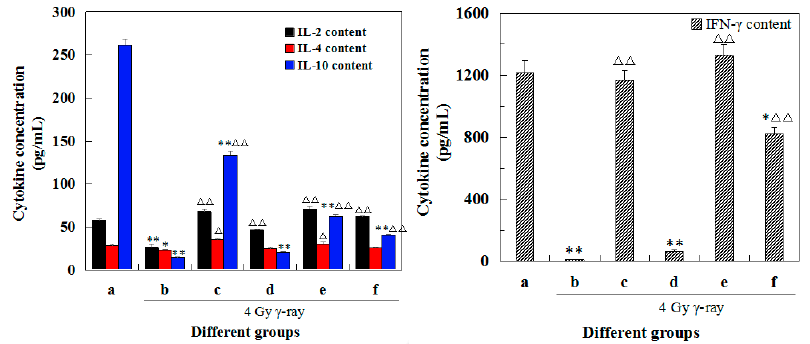
Figure 6. Effects of 5 (cid:48) -AMP on cytokine concentration in the supernatant of lymphocytes from mice treated with γ -ray irradiation (mean ± SD, n = 6). (a) Group I: Normal group; (b) Group II: Model group; (c) Group III: Positive control (berberine hydrochloride); (d) Group IV: Radiation + 5 (cid:48) -AMP (0.08 g/kgBW/day); (e) Group V: Radiation + 5 (cid:48) -AMP (0.16 g/kgBW/day); and (f) Group VI: Radiation + 5 (cid:48) -AMP (0.64 g/kgBW/day). * p < 0.05 and ** p < 0.01 compared with the normal group; ∆ p < 0.05 and ∆∆ p < 0.01 compared with the model